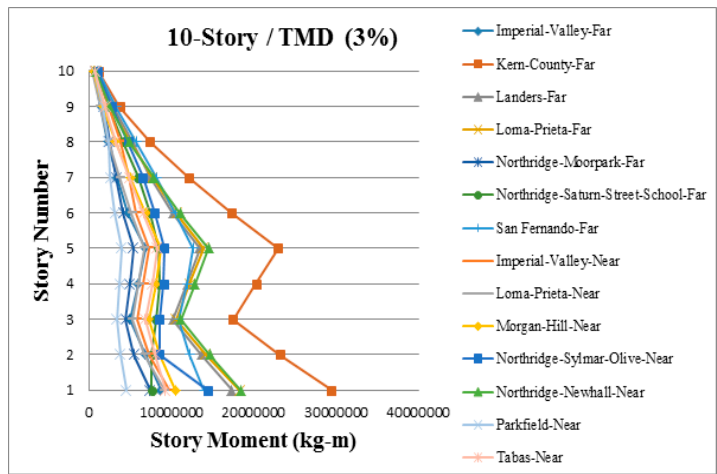
Figure 10. Peak story moments for 10-story fixed-base building with 1 tuned mass damper (TMD).